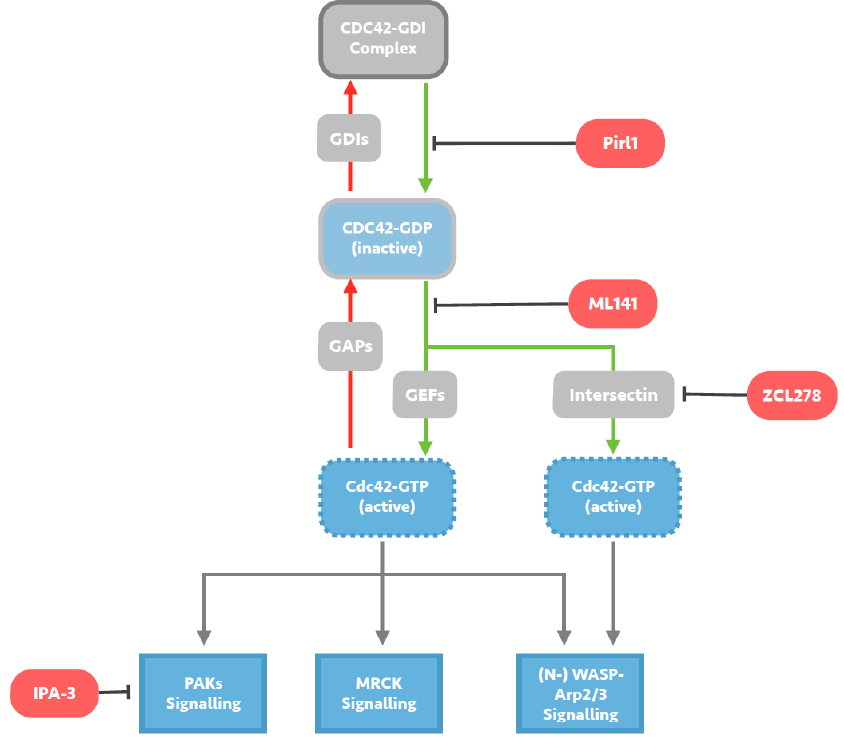
Figure 2. Mechanisms of small molecule inhibition of Cdc42 signalling. Cdc42 activity is regulated by cycling from a GTP-bound active state to a GDP-bound inactive state. Guanine exchange factors (GEFs) such as Intersectin, promote the exchange of GDP for GTP and activate Cdc42, whilst GTPase activating proteins (GAPs) catalyse the intrinsic GTPase function and inactivate Cdc42. Guanine nucleotide-dissociation inhibitors (GDIs) sequester GDP-bound Cdc42, maintaining a pool of inactive Cdc42. Pirl1 is a small molecule inhibitor of actin assembly thought to act by inhibiting activation of Cdc42/GDI complexes, precluding guanine nucleotide exchange on Cdc42 and any subsequent interaction with downstream effectors. ML141 is a selective reversible non-competitive allosteric inhibitor of Cd42, preventing GTP binding to the active site of Cdc42 without targeting any Cdc42-regulating molecules. ZCL278 acts by selectively blocking interactions between Cdc42 and the Cdc42-specific GEF Intersectin, likely predominantly preventing (N-) WASP-Arp2/3 signalling. IPA-3 is a small molecule inhibitor of downstream Cdc42 signalling, selectively inhibiting group 1 PAKs by targeting the auto-regulatory mechanism present in this group.